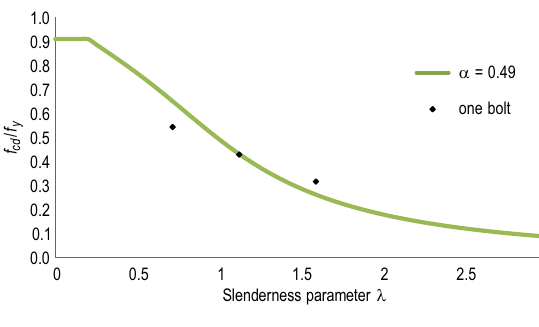
Fig. 17. Comparisons of test result for L 65 × 6 with IS 800-2007 curves ( F